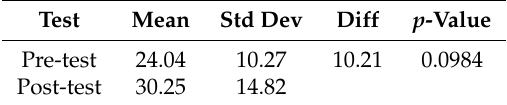
Table 2. The t -test analysis result of pre-test and post-test scores of students in the control group. Test